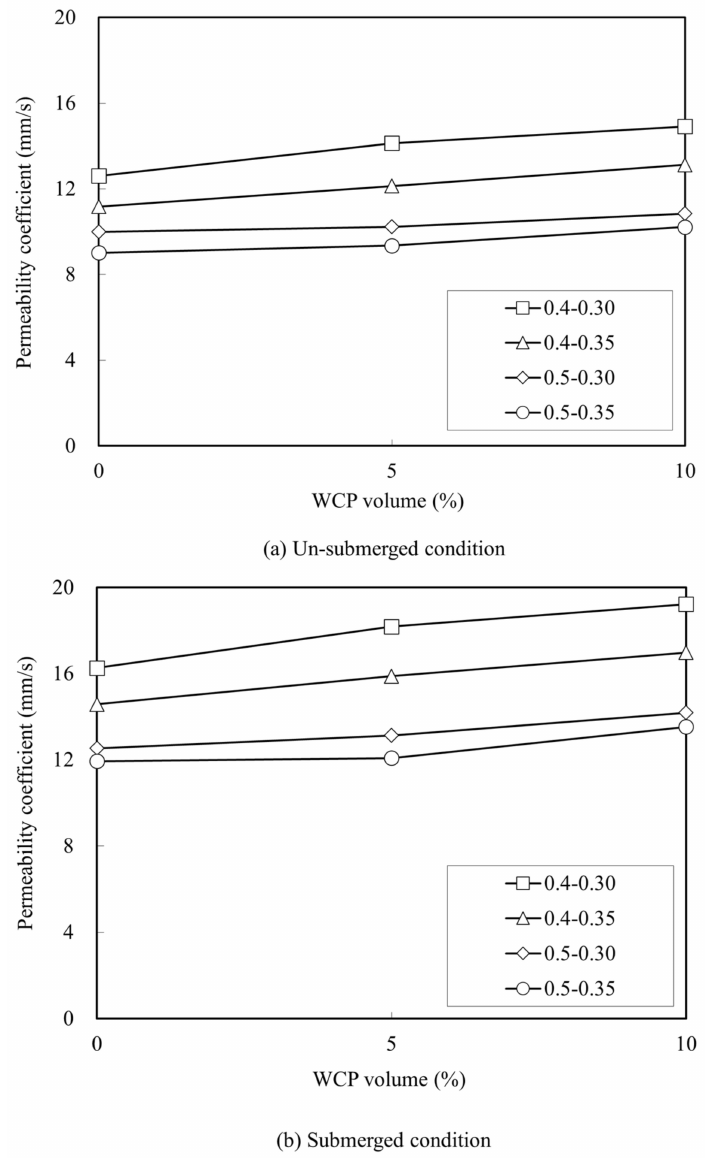
Figure 11. Variation in permeability